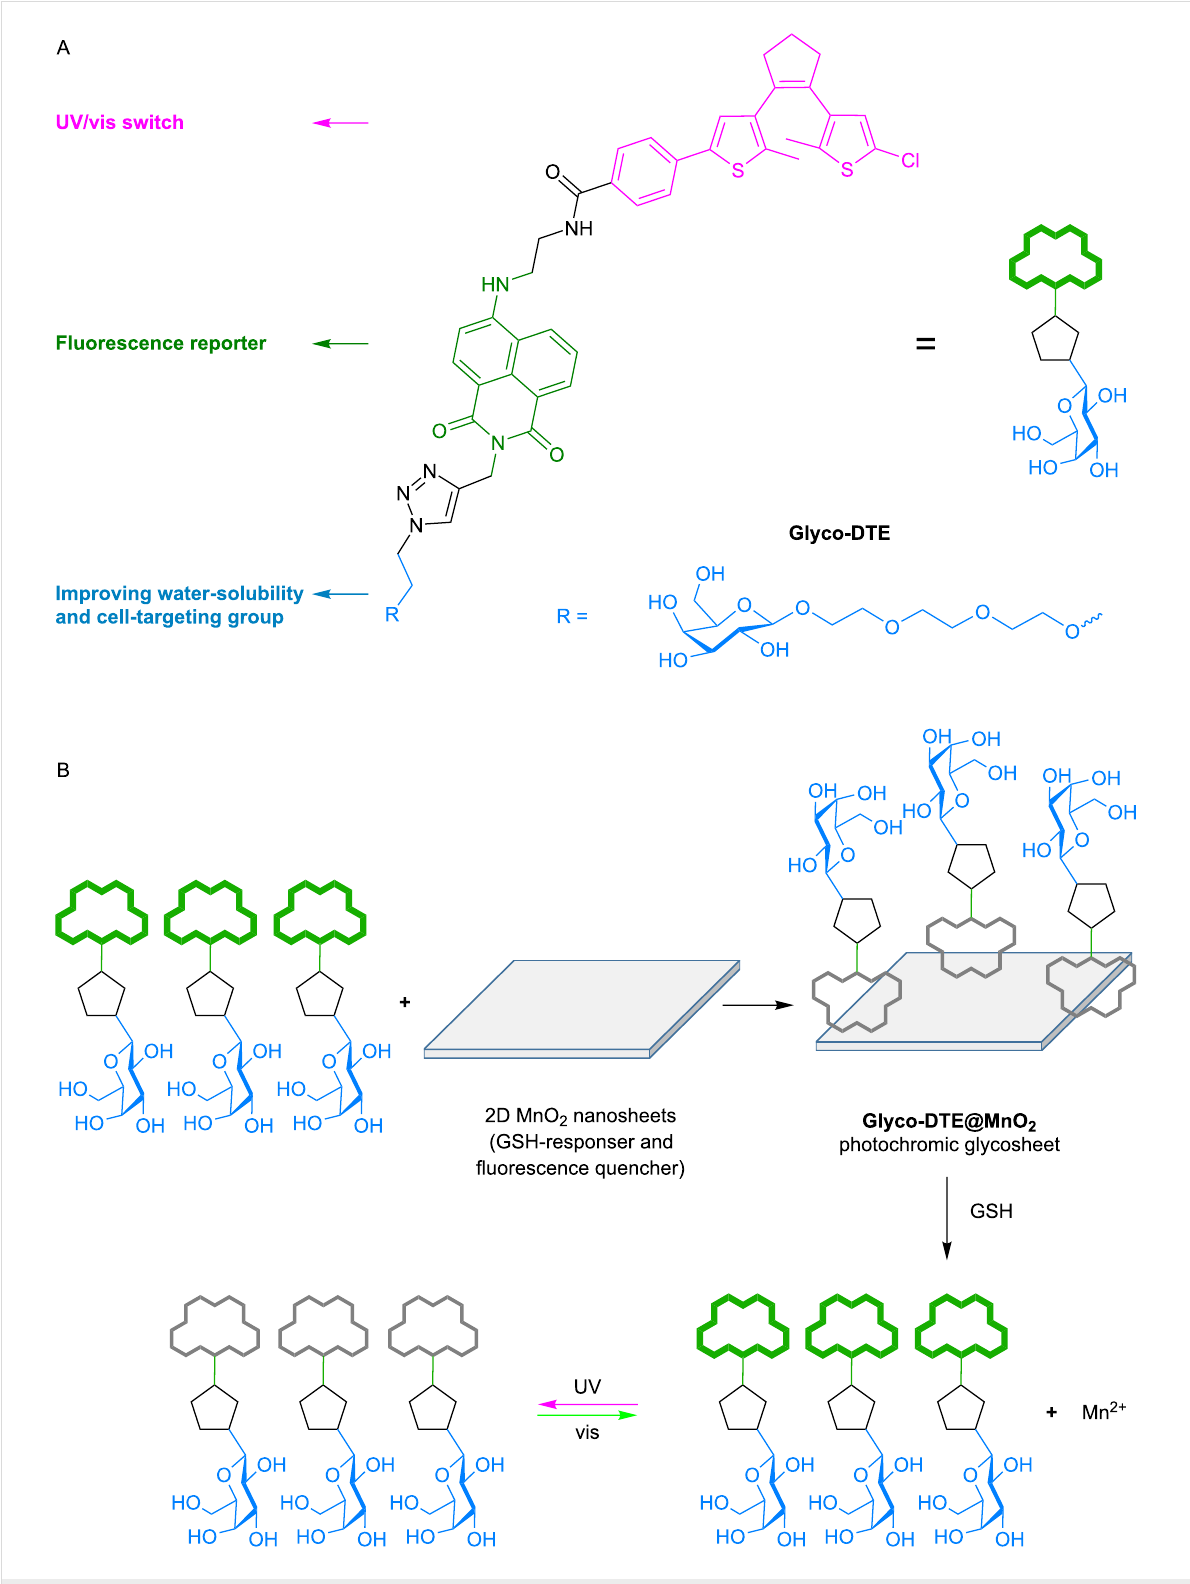
Scheme 1: The structure (A) of reporter Glyco-DTE and working principle (B) of photochromic glycosheet Glyco-DTE@MnO 2 for targeted detection and imaging of GSH in HepG2